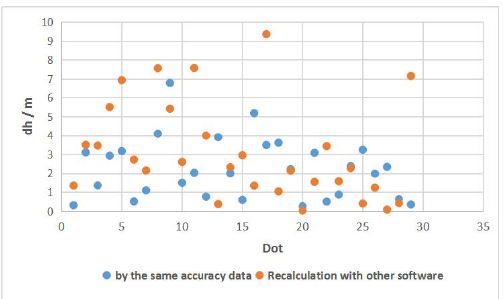
Figure 7. Errors of plane accuracy in field 3